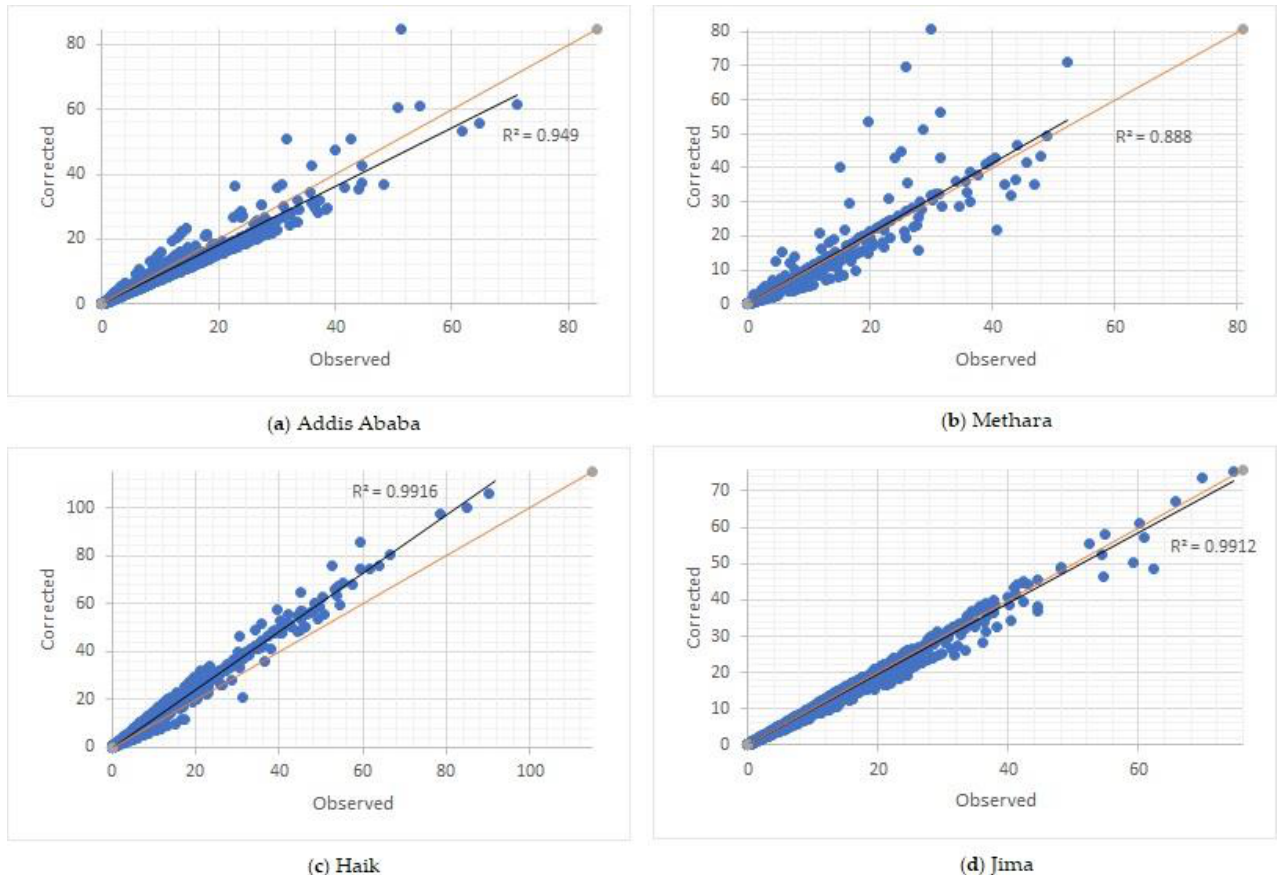
Figure 4. Observed vs. bias-corrected rainfall for selected weather stations.